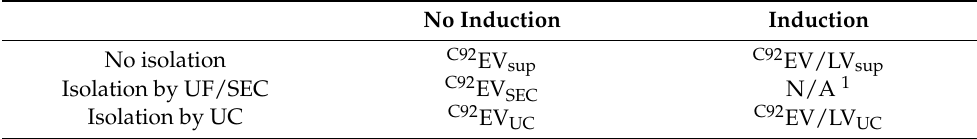
Table 1. Nomenclature for EV and LV samples in Clone 92 cell line using different isolation methods in two condition: without induction of LV production or after induction of LV production using cumate and